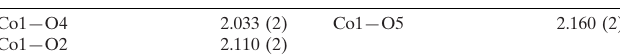
Selected bond lengths (A˚ ).